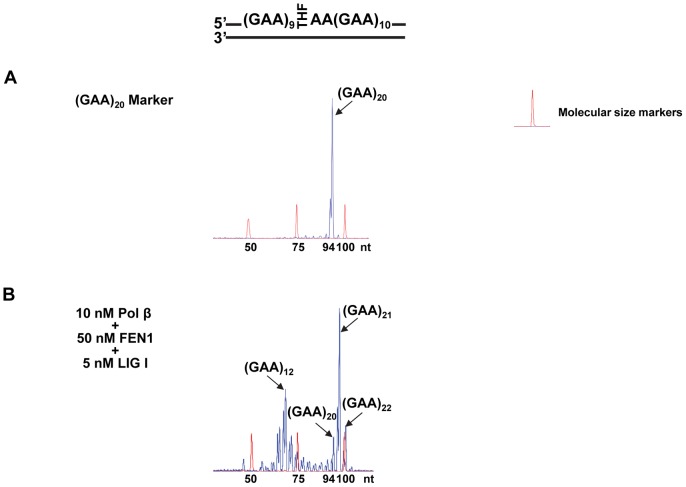
BER of an abasic lesion in the context of (GAA)20 repeats led to large GAA repeat deletions and small repeat expansions.The repair of an abasic lesion (THF residue) in (GAA)20 repeats was performed by reconstituting BER with purified BER enzymes as described in the Materials and Methods. Repaired products were then isolated and amplified by PCR and were subjected to capillary electrophoresis and DNA fragment analysis. Panel A illustrates the results of DNA fragment analysis of a (GAA)20 repeat-containing marker without any DNA damage. Panel B represents the DNA fragment analysis results of repair products from the reconstituted BER. Size standards are indicated.